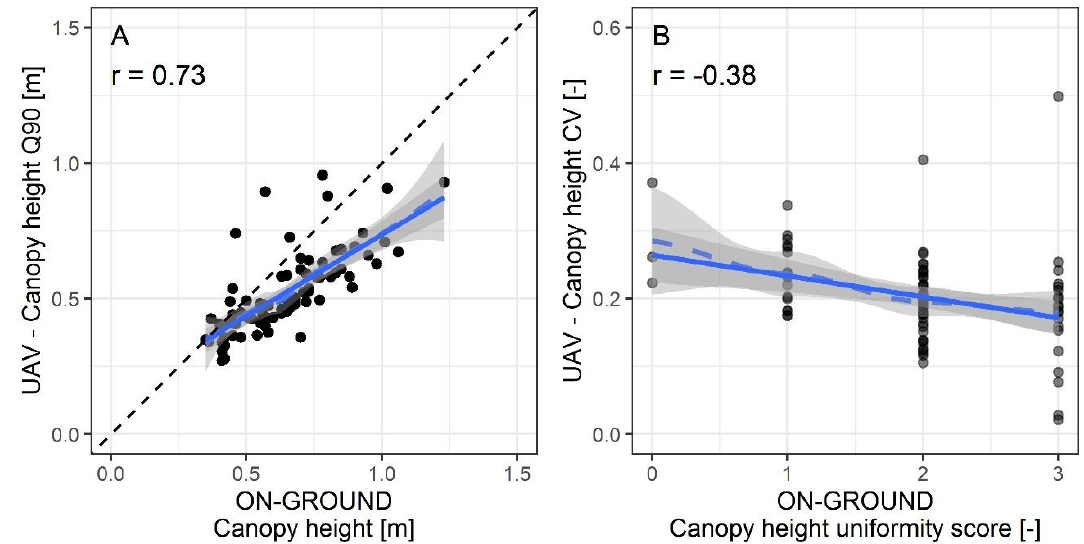
Figure 4. ( A ) Correlations between the manually measured canopy height (GR_Hmax) and the drone-derived canopy height (UAV_HQ90) in the rose trial, and ( B ) between the visual score of the canopy height uniformity (GR_U) and the drone-derived canopy height coefficient of variation (UAV_Hcv), respectively, for 5 September 2019.